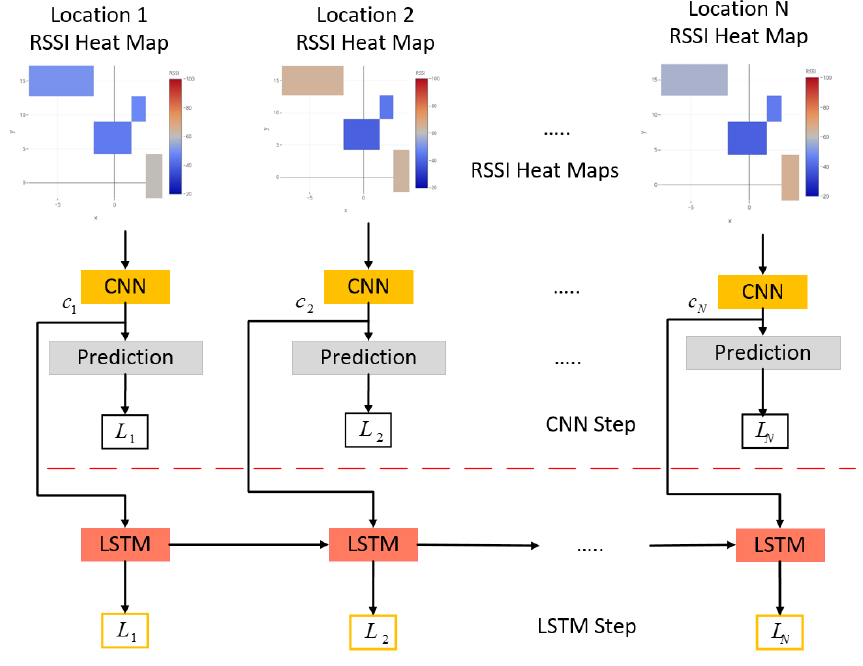
Figure 2. Proposed hybrid deep learning model (HDLM).